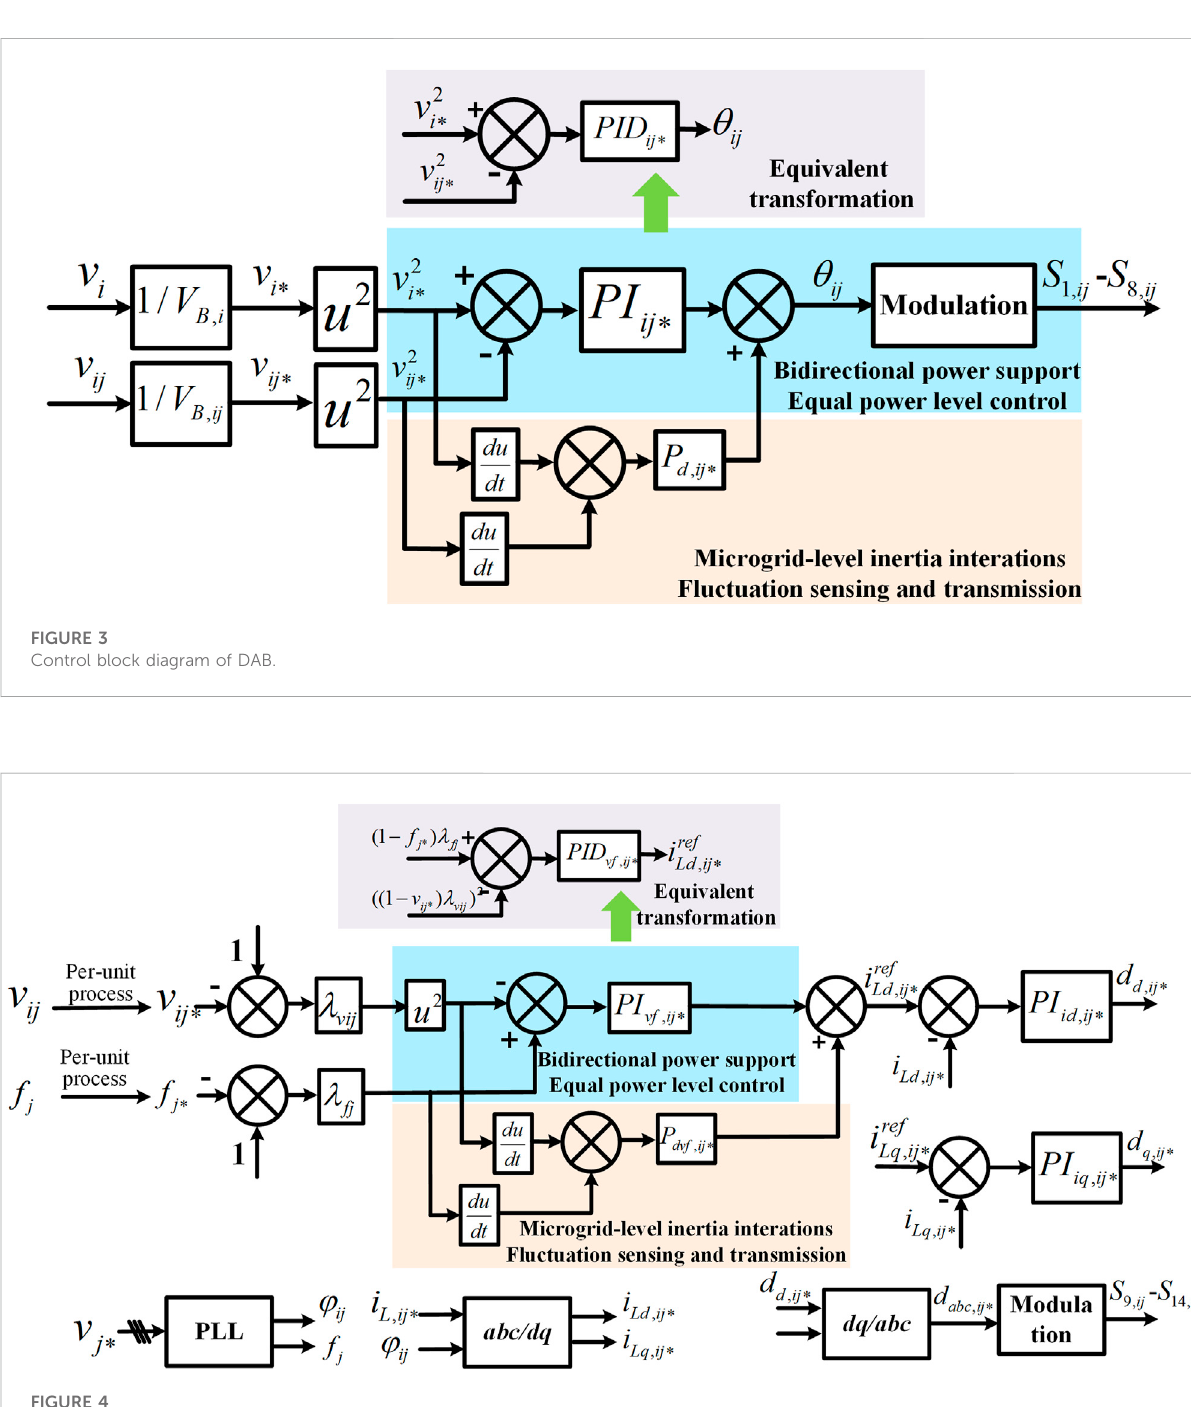
FIGURE 4 Control block diagram of